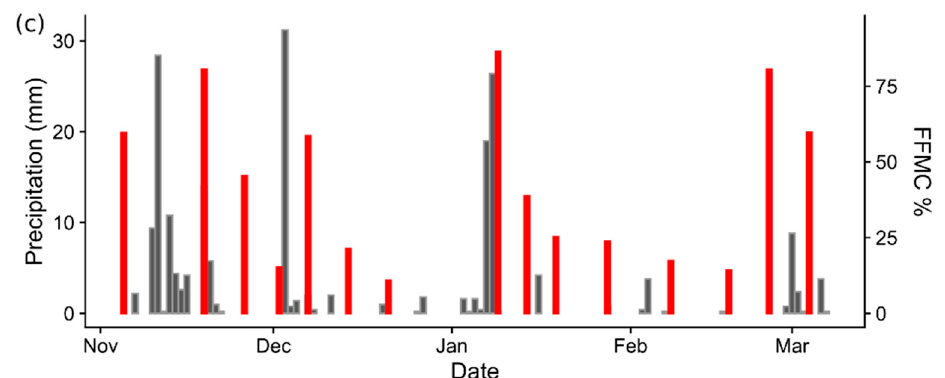
Figure 3. Precipitation and forest fire danger index prior to and during the 2021–2022 summer field campaign at Hobart, Tasmania. ( a ) Rain over preceding year (grey bars) and Forest Fire Danger Index (FFDI) (red line) based on data from nearest meteorological station (Hobart) for 12 months including 3-month sampling period. ( b ) Rainfall (grey bars) and Soil Dryness Index (SDI) (blue line) [20] during summer sampling campaign (defined by the dashed lines on the time axis of panel ( a ), where red dots indicate sampling dates. ( c ) Rainfall (grey bars) and mean gravimetric fine fuel moisture content percentage (FFMC) (red bars) on measurement dates during summer sampling cam- paign.